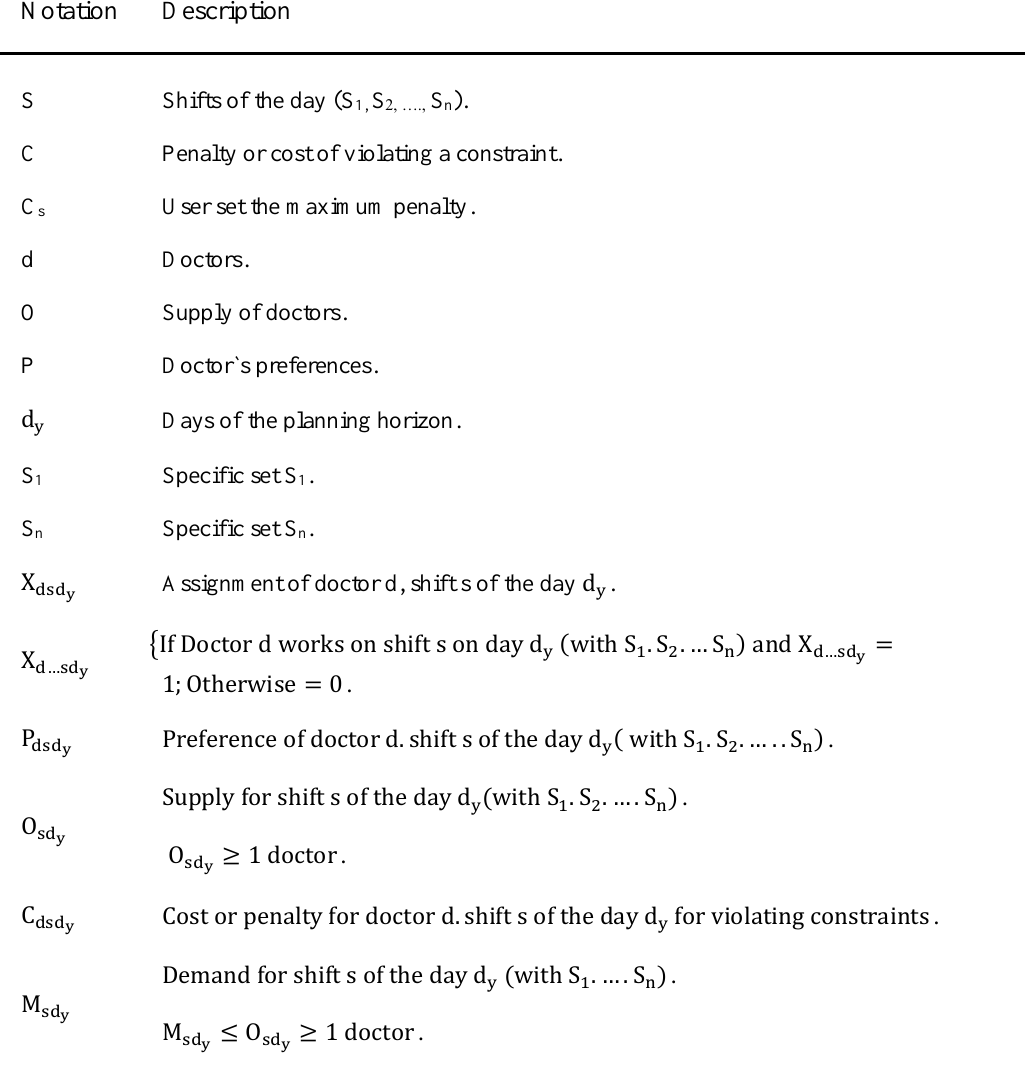
Table 3. Description of the Used Set of Values and